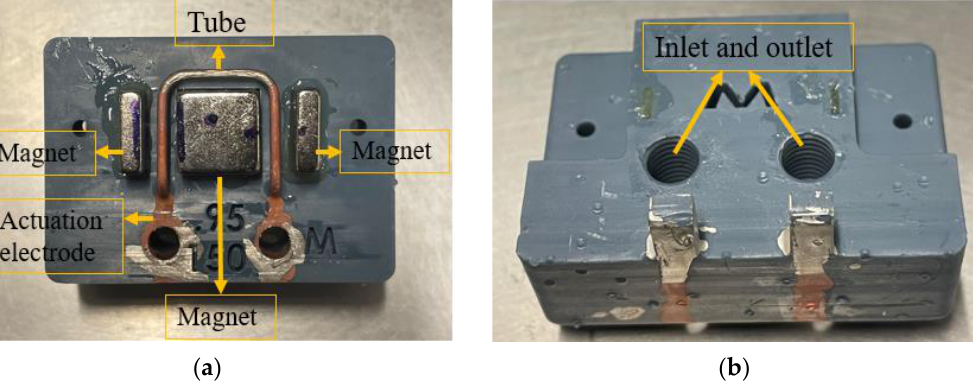
Figure 6. Photographs of the 3D-printed Coriolis mass flow sensor: ( a ) top view and ( b ) bottom view.